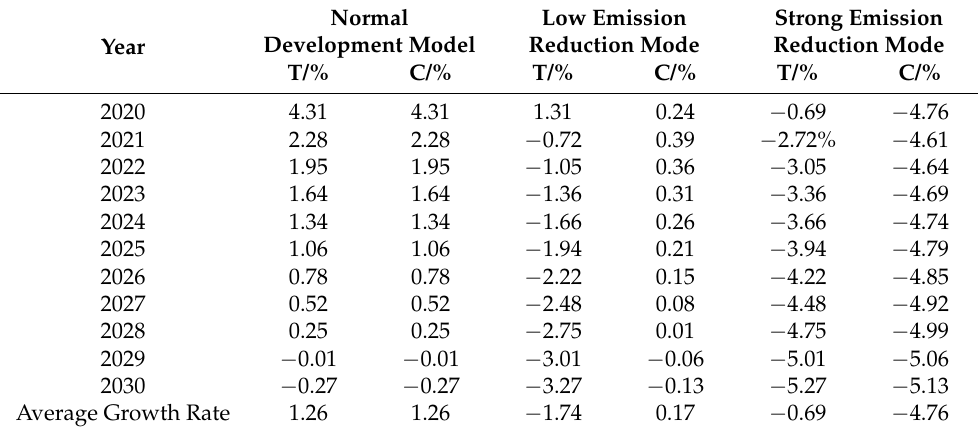
Note: G in the table stands for GDP, P in the table stands for population, U in the table stands for urbanization ratio, and E in the table stands for electricity consumption of the whole society. Table 5. Growth rate of environmental variables of thermal coal demand in Shanxi Province in multiple